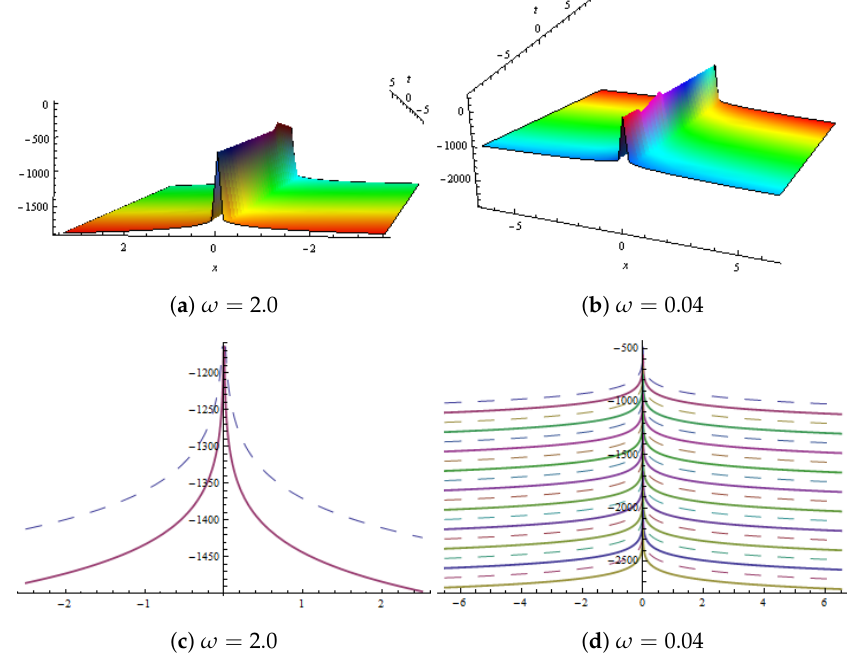
Figure 9. ( a , b ) show 3D plots and ( c , d ) show 2D